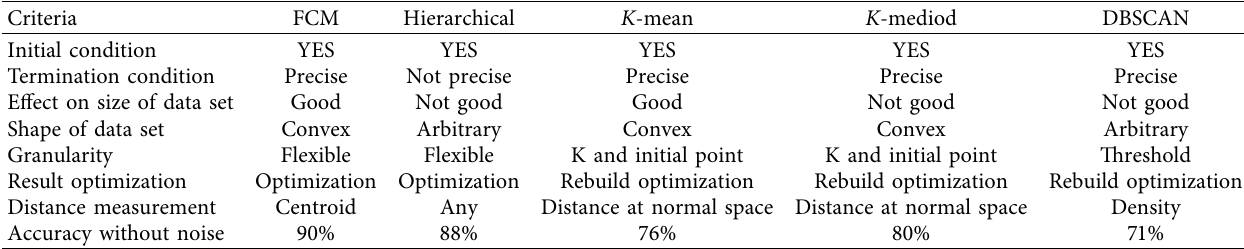
Table 2: Comparison of different clustering algorithms.